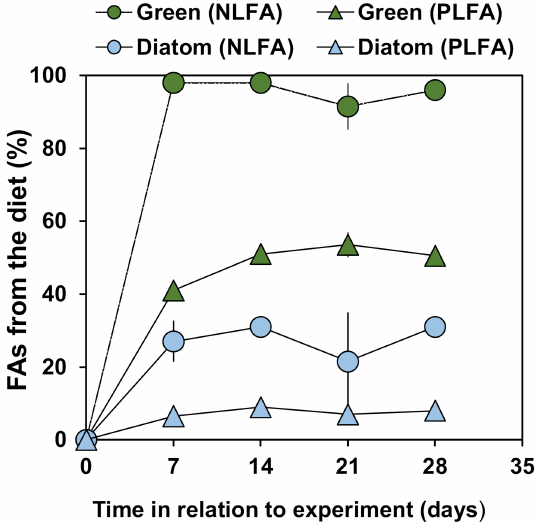
Figure 5. The contribution of fatty acids (FAs) derived from the diet in an amphipod ( Pallaseopsis quadrispinosa ). Two lipid fractions assessed for (a) green algae ( Acutodesmus sp.) and (b) diatom ( Diatoma tenuis ) diets. The values were obtained from a mixing model that obtained the best fit between the observed FA profile and a hypothetical mixed profile derived using end members from the initial diets (see